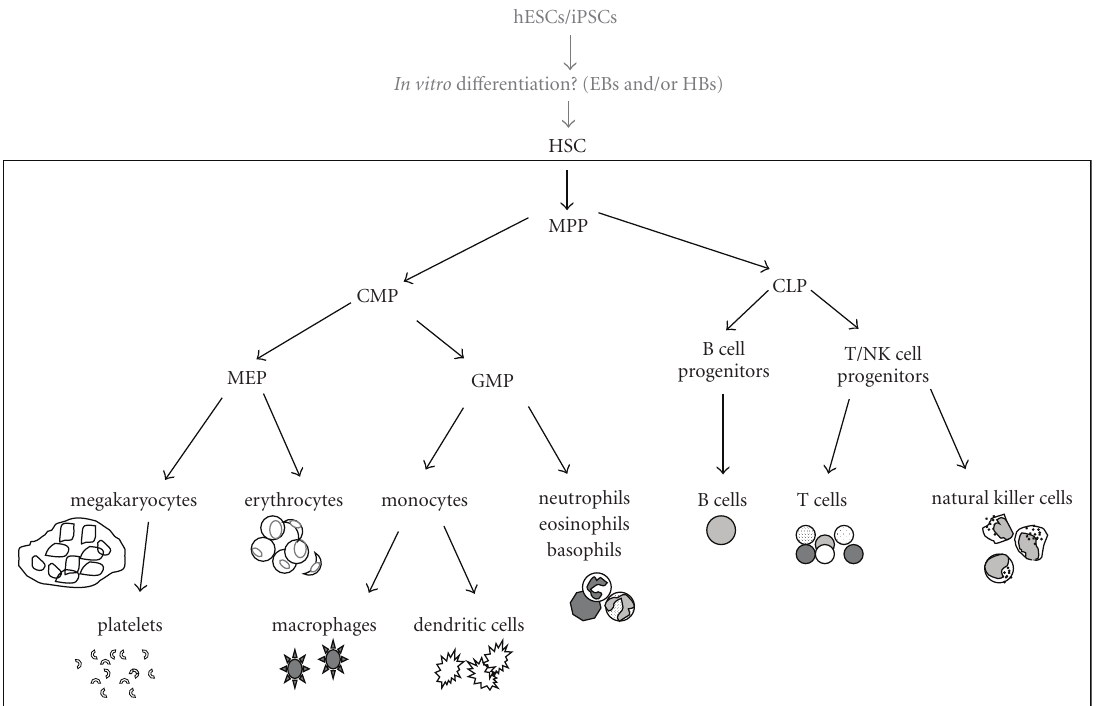
Figure 1: Simplified schematic of hematopoietic di ff erentiation. At the top, hESCs and/or iPSCs may be able to recapitulate hematopoietic di ff erentiation in vitro after initial di ff erentiation into EBs and/or HBs intermediates. These culture-based intermediates di ff erentiate into cells similar to mesoderm-derived HSC/progenitors. The boxed region shows hematopoietic di ff erentiation as it is thought to occur in vivo . HSCs undergo successive stages of di ff erentiation to give rise to progenitor cells in both the myeloid lineage (left side) and lymphoid lineage (right side). These progenitors will undergo further di ff erentiation to eventually give rise to mature cells within the peripheral